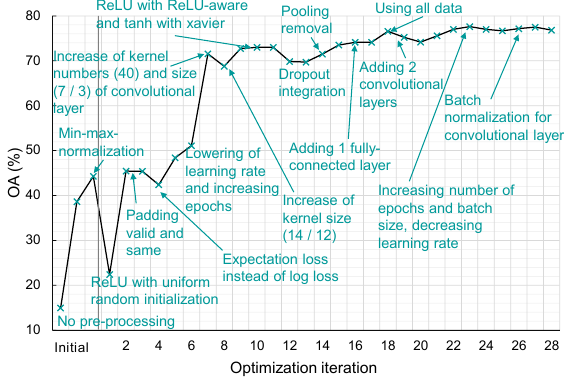
Figure 2. Most important adaptations concerning the improvement of model accuracy (OA of the test